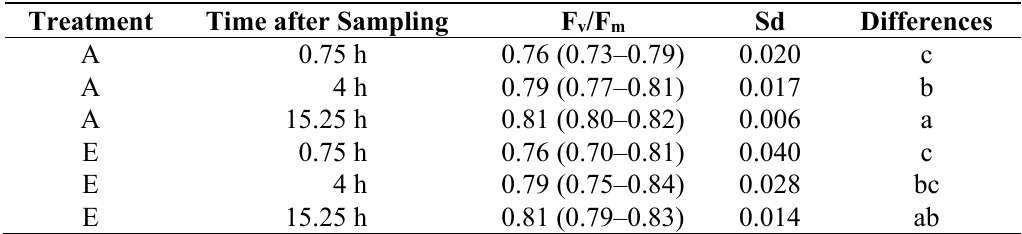
Table 3. Bologna FACE (E) and ambient control (A) plots. n = 8 leaves per treatment. F v /F m mean with lowest and highest genotype mean in parentheses. Sd = standard